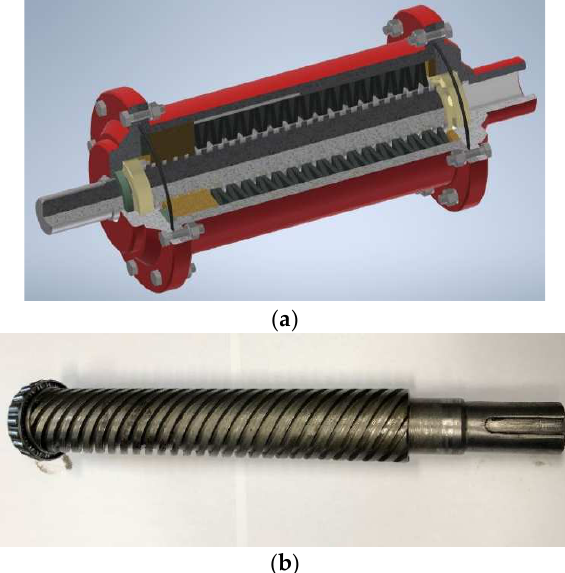
Figure 3. Design of the flexible metal clutch: ( a ) model, ( b ) actual screw.